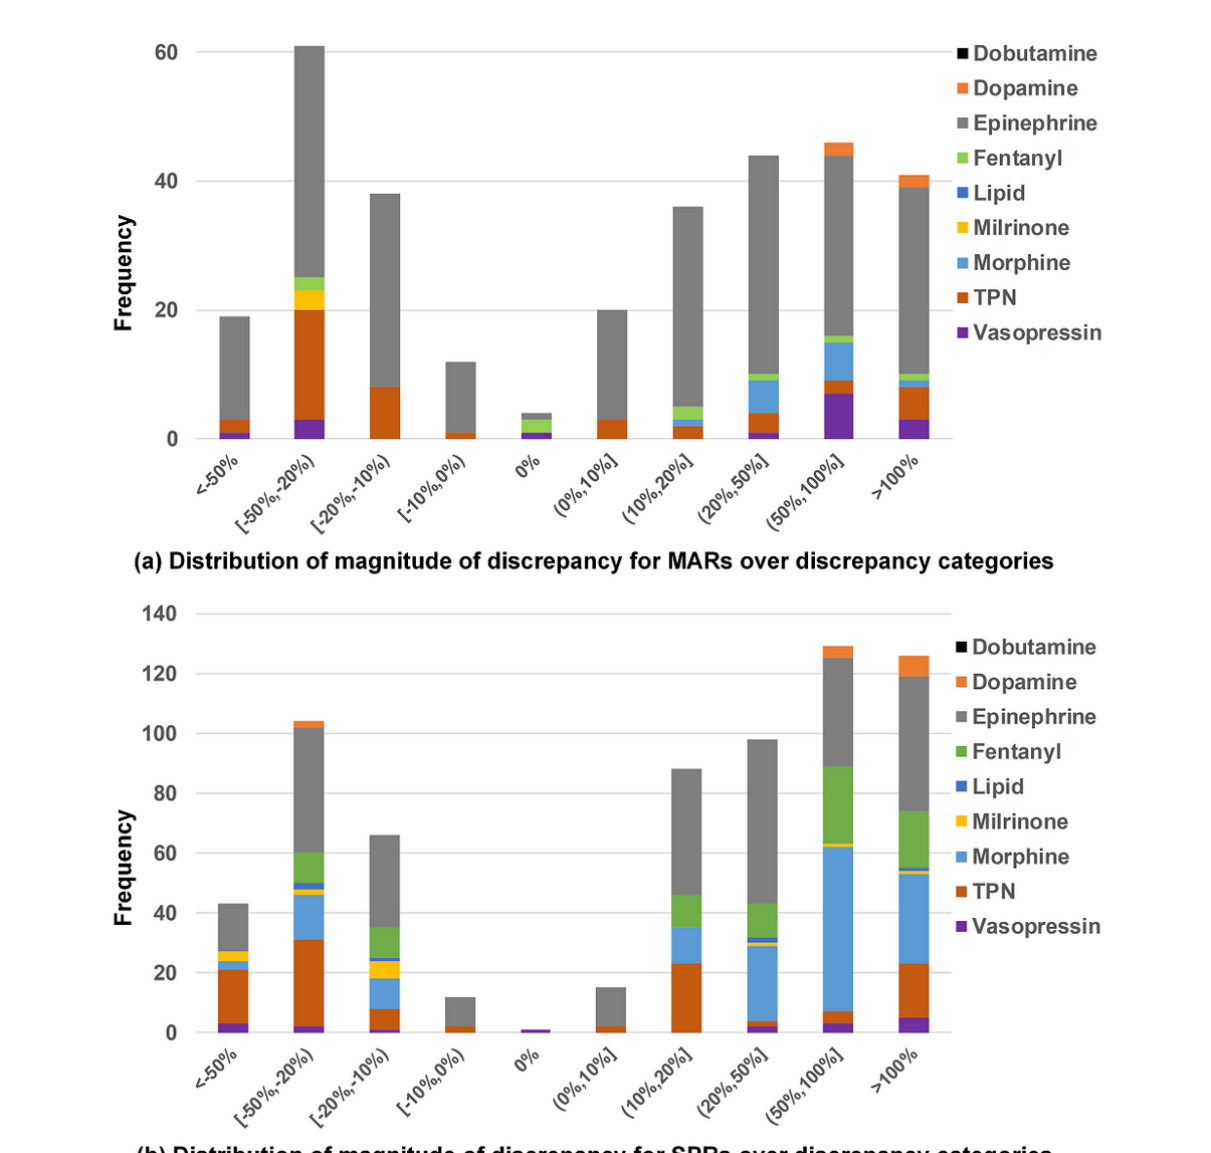
Figure 2. Distribution of magnitude of discrepancy for (a) medication administration records and (b) smart pump records over discrepancy categories. MARs: medication administration records; SPRs: smart pump records; TPN: total parenteral